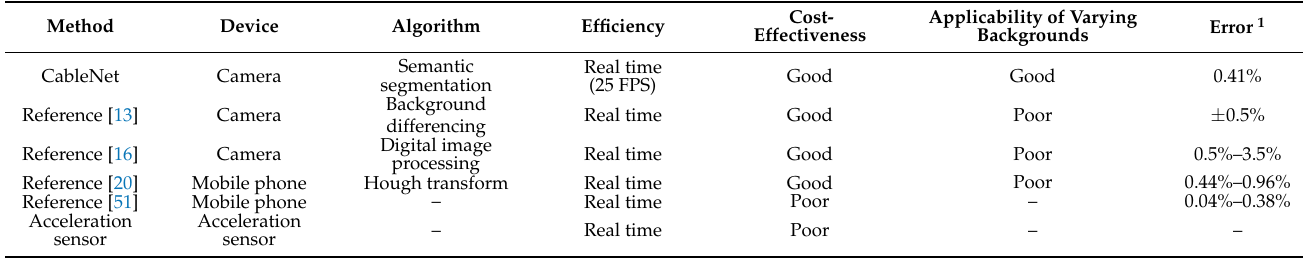
Table 21. Comparative study of CableNet, existing acceleration sensor-leveraged method, and method proposed by references.